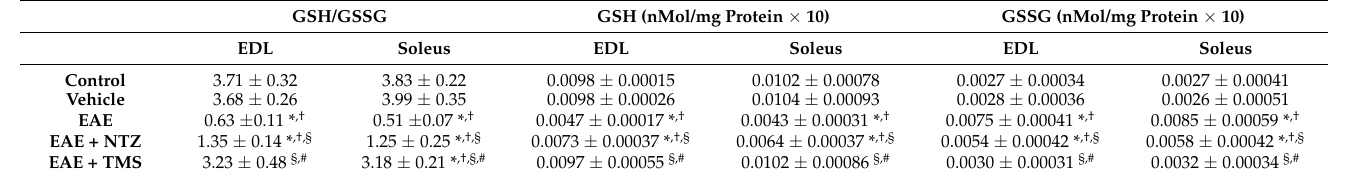
Table 1. Antioxidant enzymatic activities in EDL and soleus muscles of the different groups.